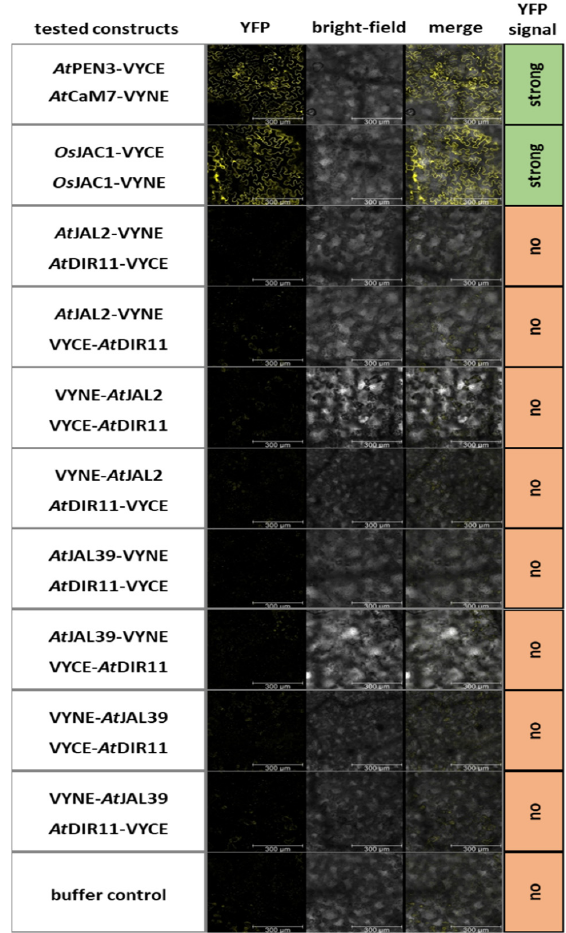
Figure 5. Bimolecular fluorescence complementation assay of Arabidopsis JRL and DIR candidates. Leaves of N. benthamiana were transformed via Agrobacterium tumefaciens, resulting in the co-expres- sion of the constructs as indicated. The pairs At PEN3 and At CAM7, as well as Os JAC1/ Os JAC1, served as the positive controls. An evaluation of YFP fluorescence (YFP) was performed using con- focal laser scanning microscopy two days after the transformation at 20x magnification, excitation at 514 nm, and detection at 518–550 nm ( n = 3). Additionally, bright-field pictures were taken, and merged images of the aforementioned pictures are shown for the localization of the YFP signal. Scale bar: 300 µm.